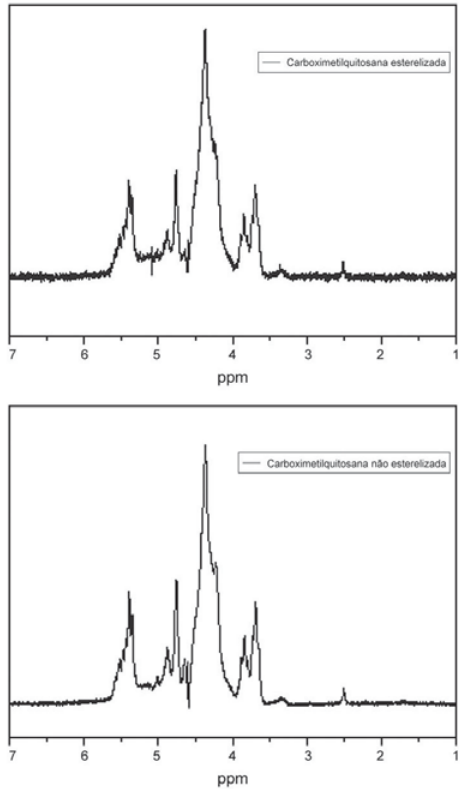
Fig. 2 - Espectroscopia de ressonância magnética nuclear de hidrogênio (1H RMN)